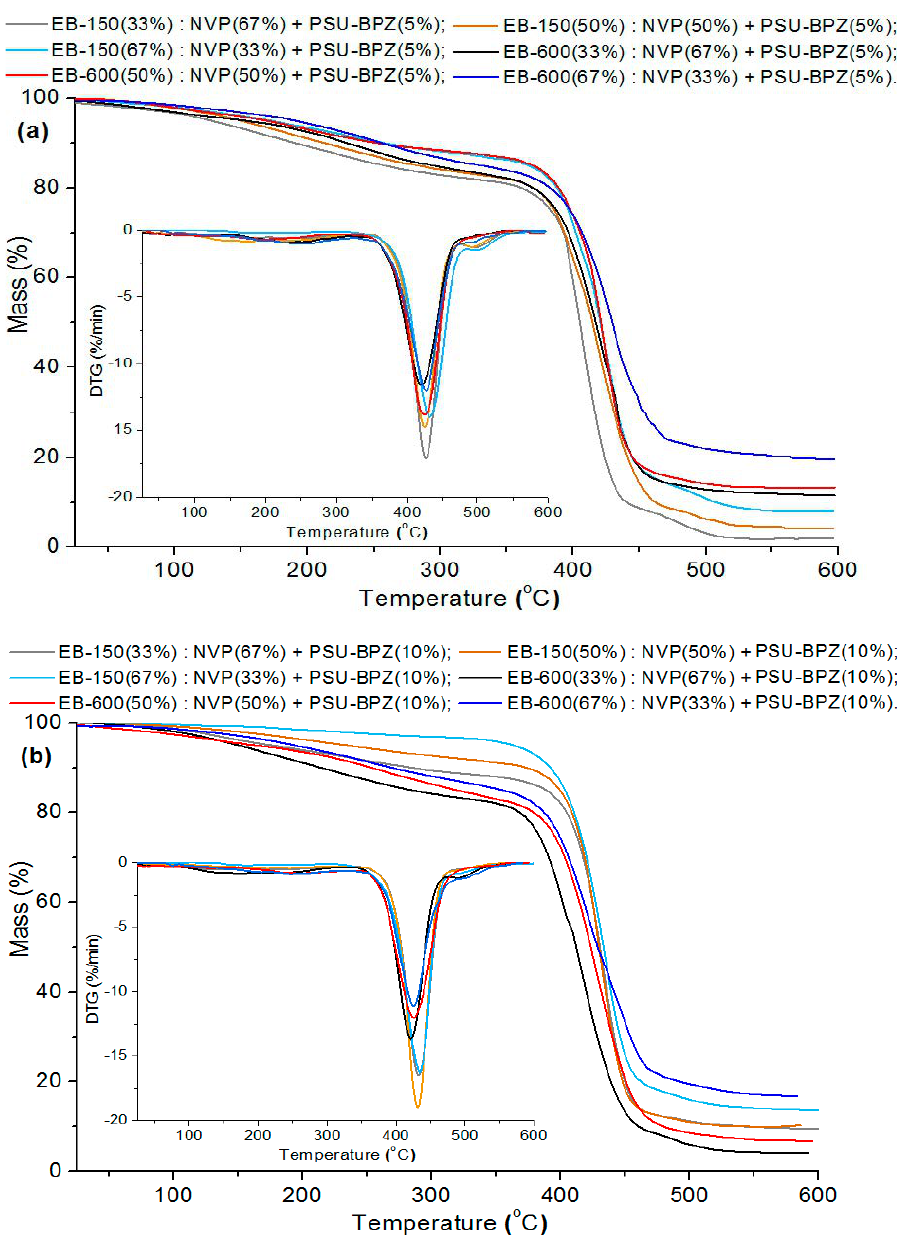
Figure 9. Thermal analysis: TG/DTG curves of blends: ( a ) for materials with 5 wt.% of PSU-BPZ; ( b ) for materials with 10 wt.% of PSU-BPZ. Table 4. Numerical values of the thermogravimetry analysis of the bisphenol Z polysulfone and copolymers without dopant.